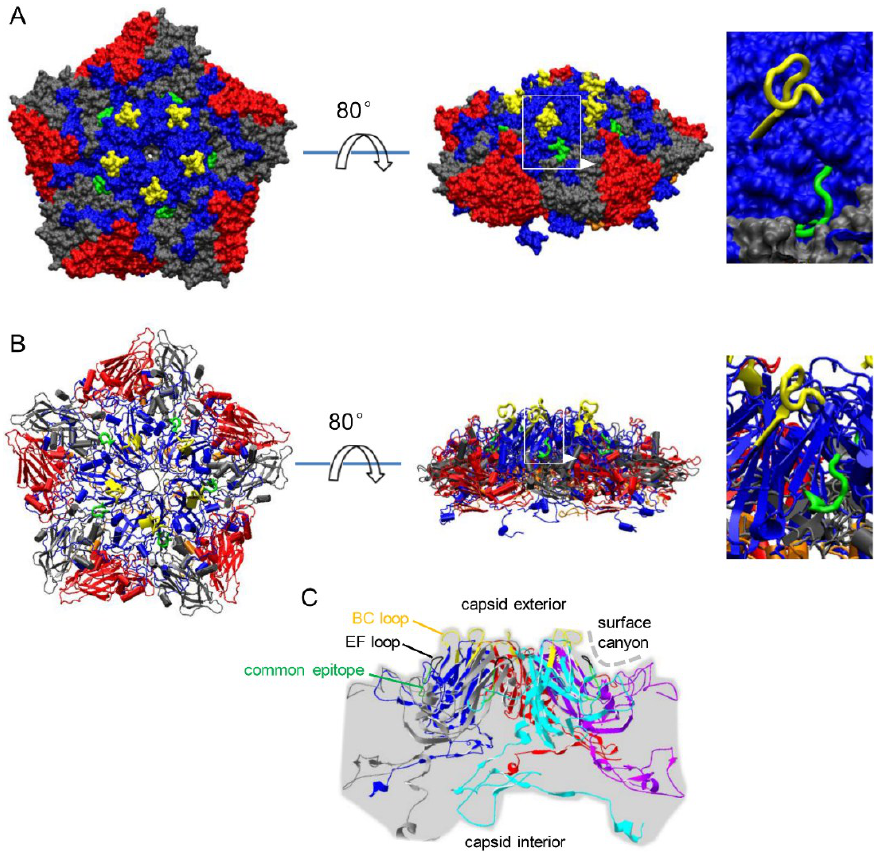
Figure 2. Location of common epitope on the viral capsid surface. ( A ) A pentamer (VP1, blue; VP2, red; VP3, gray; VP4, orange) of the EV71 viral capsid (pdb ID: 3VBS) is shown as an electrostatic surface model, where the common epitope is highlighted in green, and the BC loop is highlighted in yellow; ( B ) the cartoon of the pentamer of which color scheme is identical to that in panel A; and ( C ) the location of common epitope is indicated and localized with BC loop and EF loop in the pentamer of VP1. Colors of these five VP1 copies were assigned